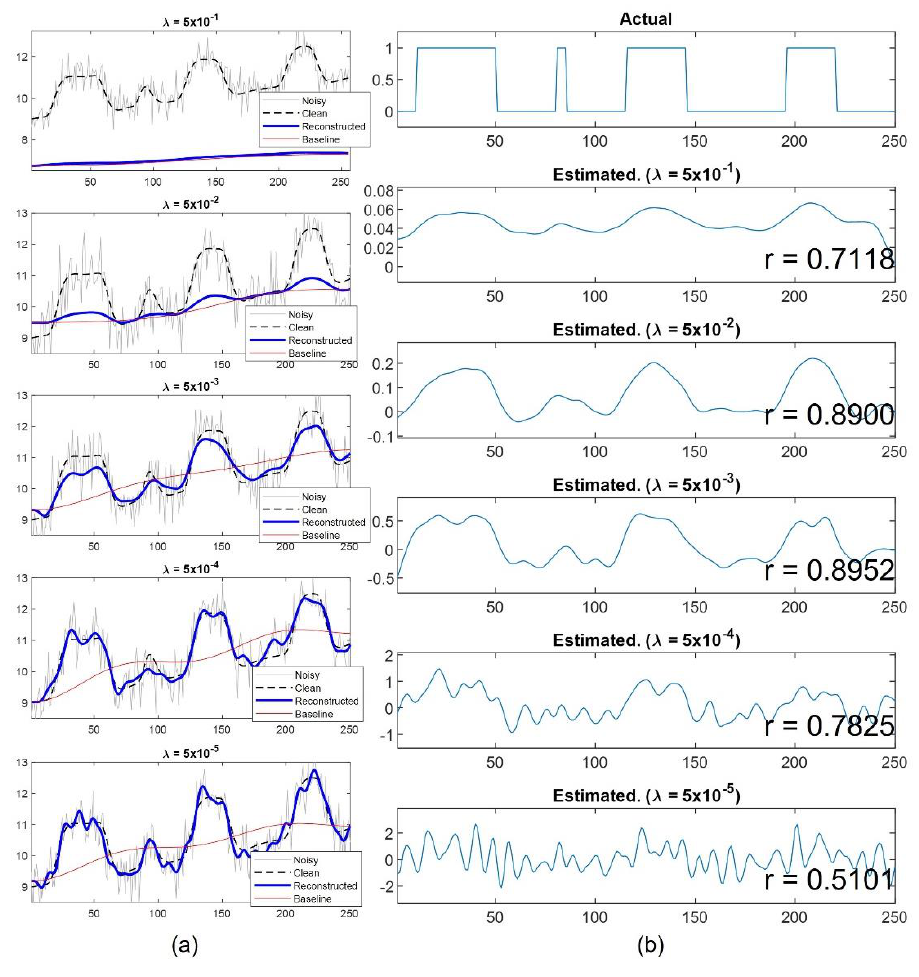
Figure A2. Comparison of the ( a ) time series reconstruction and ( b ) the estimated pseudo-stimulus for different regularization constant. Varying regularization constant values are indicated on the top of the subplots.